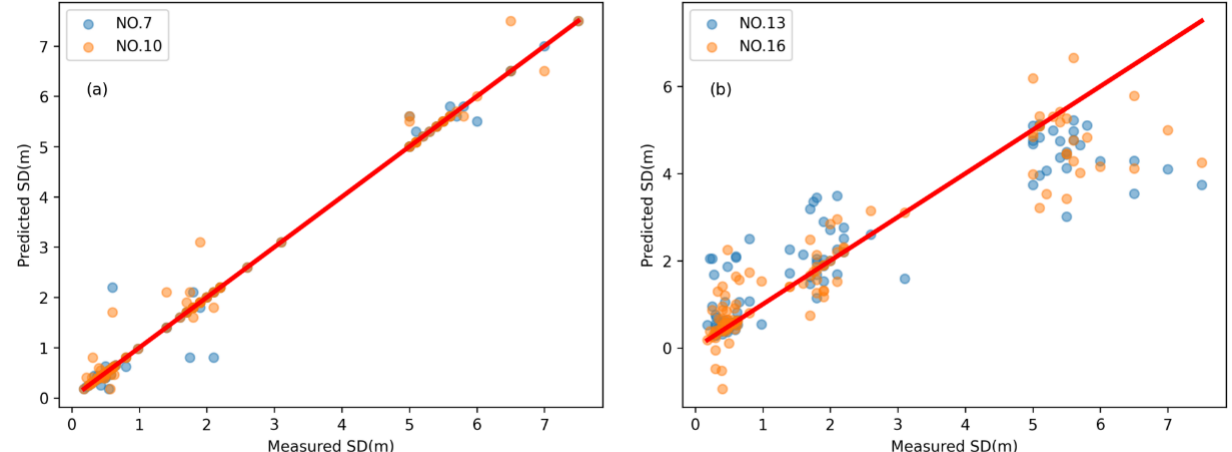
Figure 4. Scatter plot of the measured Secchi depth (SD) and predicted SD of the optimal solutions for different groups of spectral variables corresponding to MLP and SVM models. ( a ) The optimal solutions for the MLP model for different groups of spectral variables. ( b ) The optimal solutions for the SVM model for different groups of spectral variables. The experiment number corresponds to Table 3. The blue points represent models using spectral variables in a single band or band combination. The orange points represent models using spectral variables in band combination and band ratio combination.